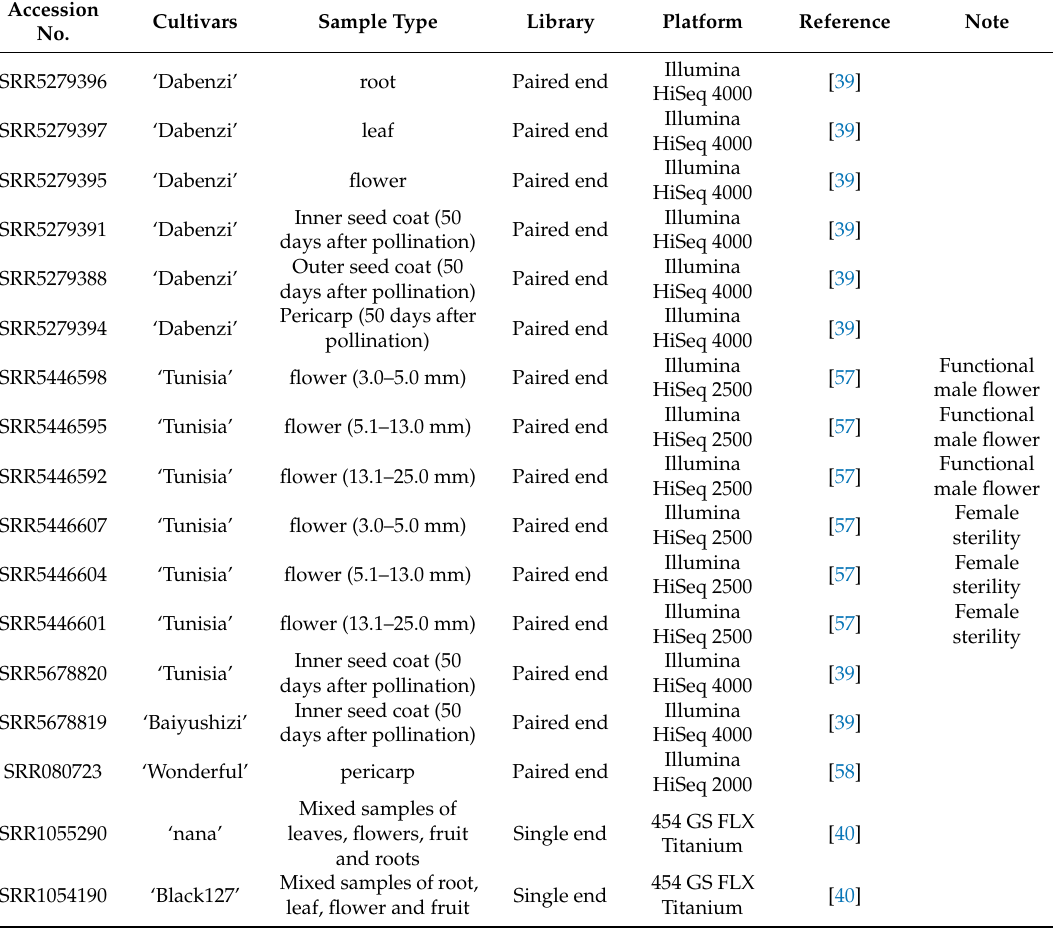
Table 1. RNA-Seq data of